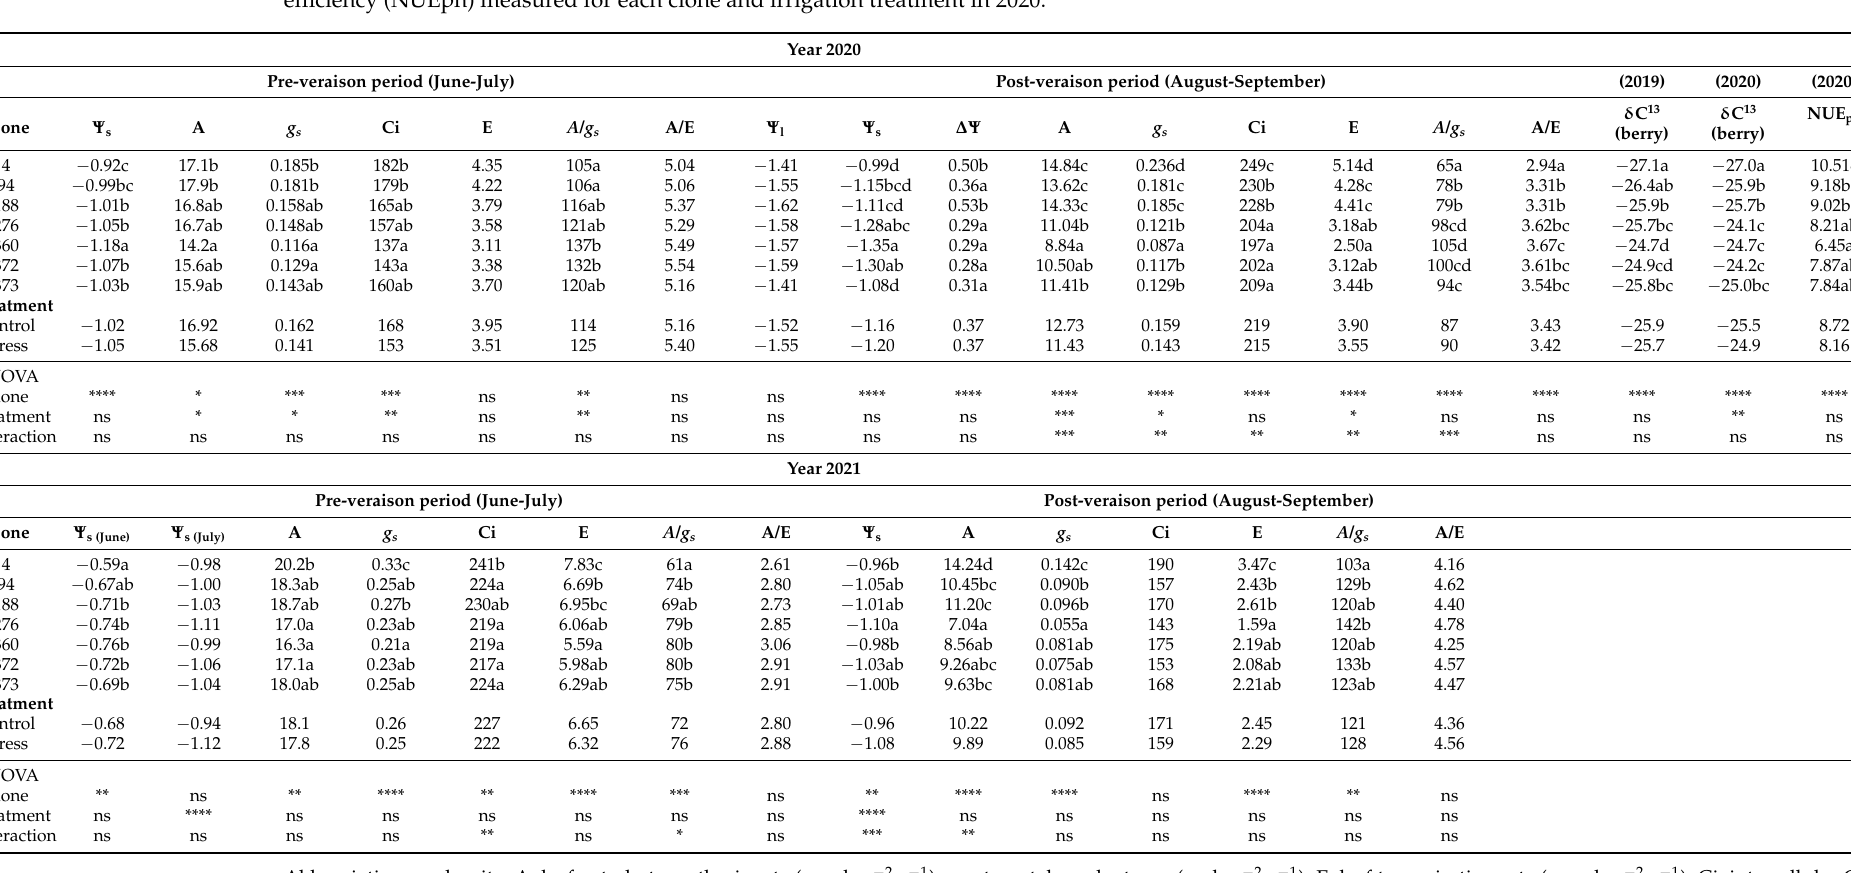
Table 3. Average values of Ψ s, midday stem water potential (MPa), Ψ l , leaf water potential (MPa), early morning leaf gas exchange parameters measured during pre- and post-veraison periods for each clone, irrigation treatment and their interaction (clone × irrigation treatment) for years 2020 and 2021. Mean values of 13 C isotope discrimination ( δ C 13 ; ‰) measured at harvest in berries from different combinations of clones-irrigation treatment in 2019 and 2020. Photosynthetic nitrogen use efficiency (NUEph) measured for each clone and irrigation treatment in